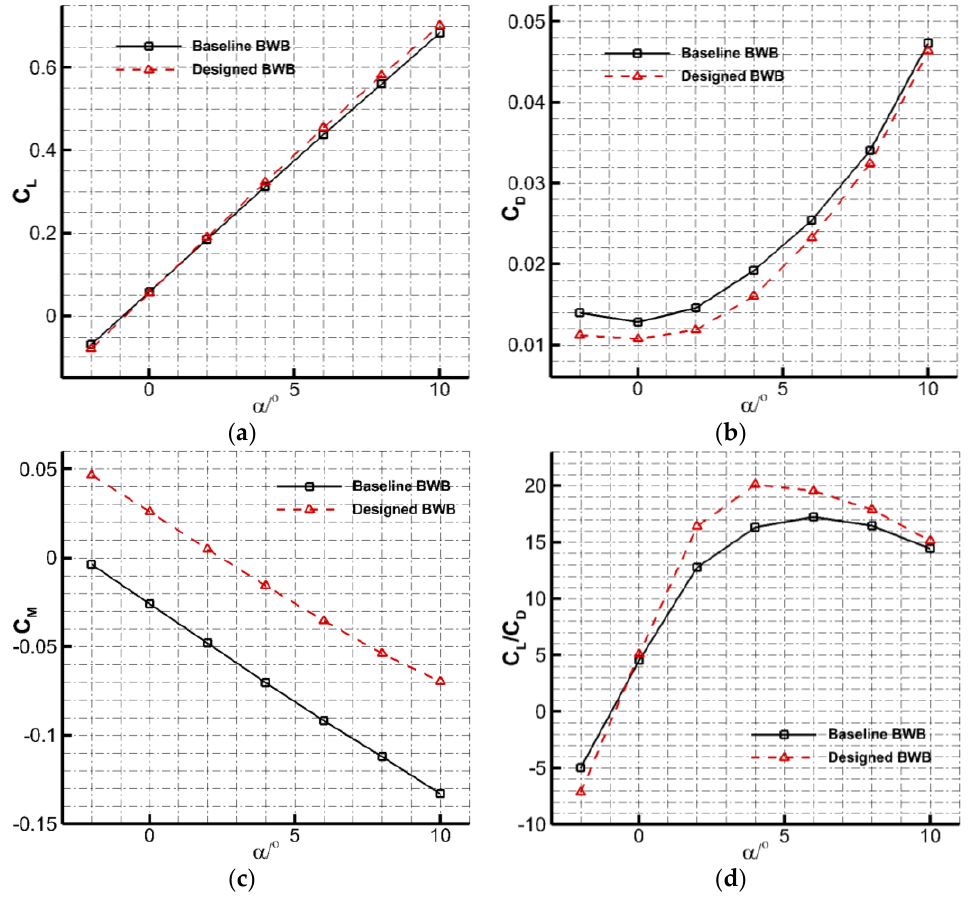
Figure 13 . Comparison of aerodynamic performance of the BWB configuration. ( a ) Lift performance. (b) Drag performance. (c) Pitching performance. (d) Lift-to-drag performance.